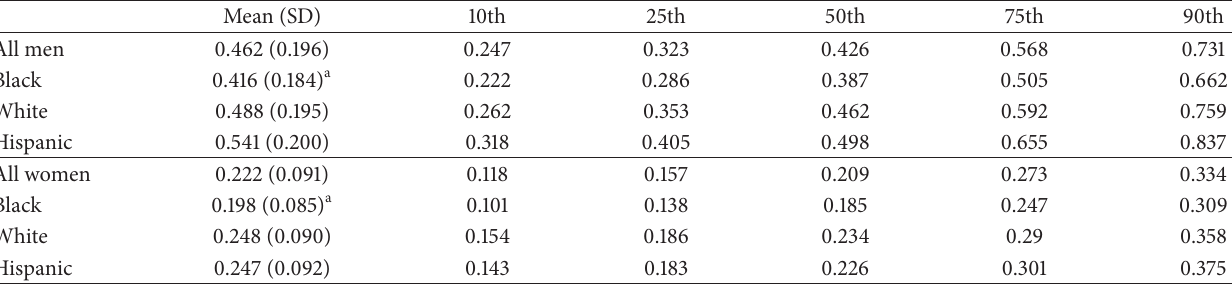
Table 2: Distribution of intraperitoneal/abdominal subcutaneous fat ratio.